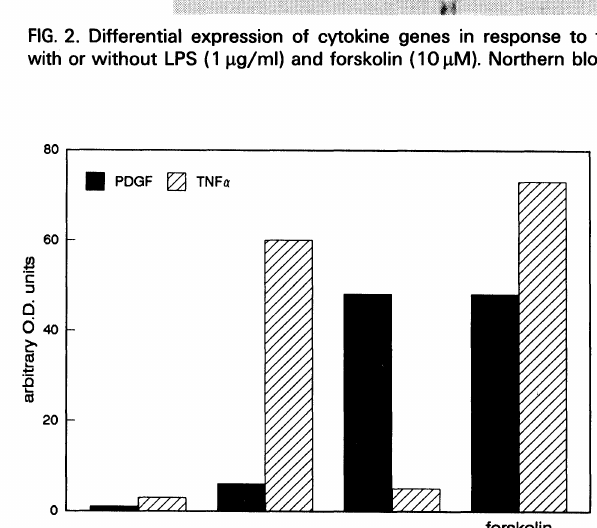
FIG. 3. Expression of PDGF B chain and TNF- mRNAs. Blots were prepared from ANA-1 cells following 4h of culture with or without LPS (1 Ig/ml) in the presence or absence of